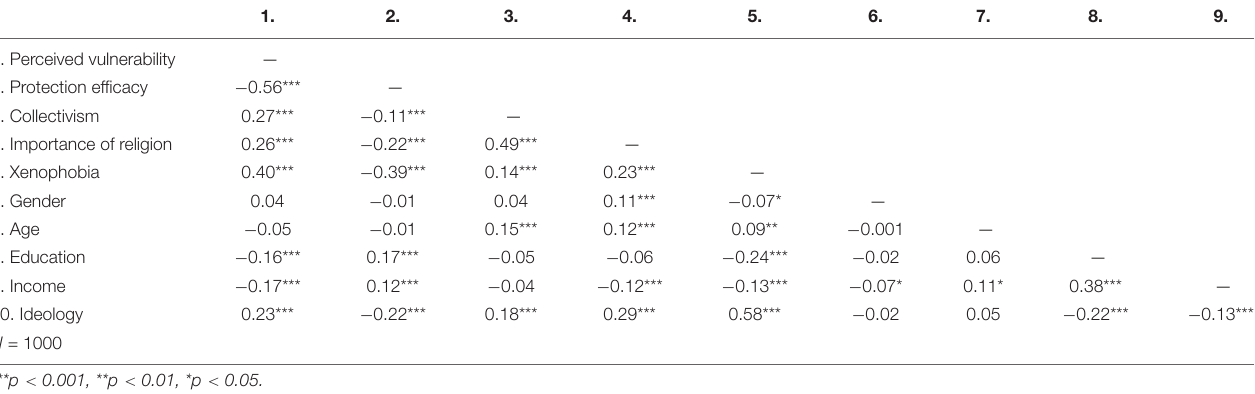
TABLE 1 | Bivariate correlations among variables.